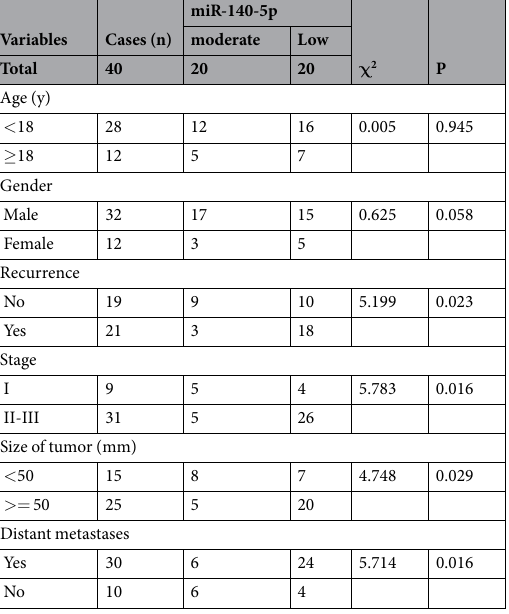
Table 1. Relationship between expression of miR-140-5p and clinicopathologic characteristics of